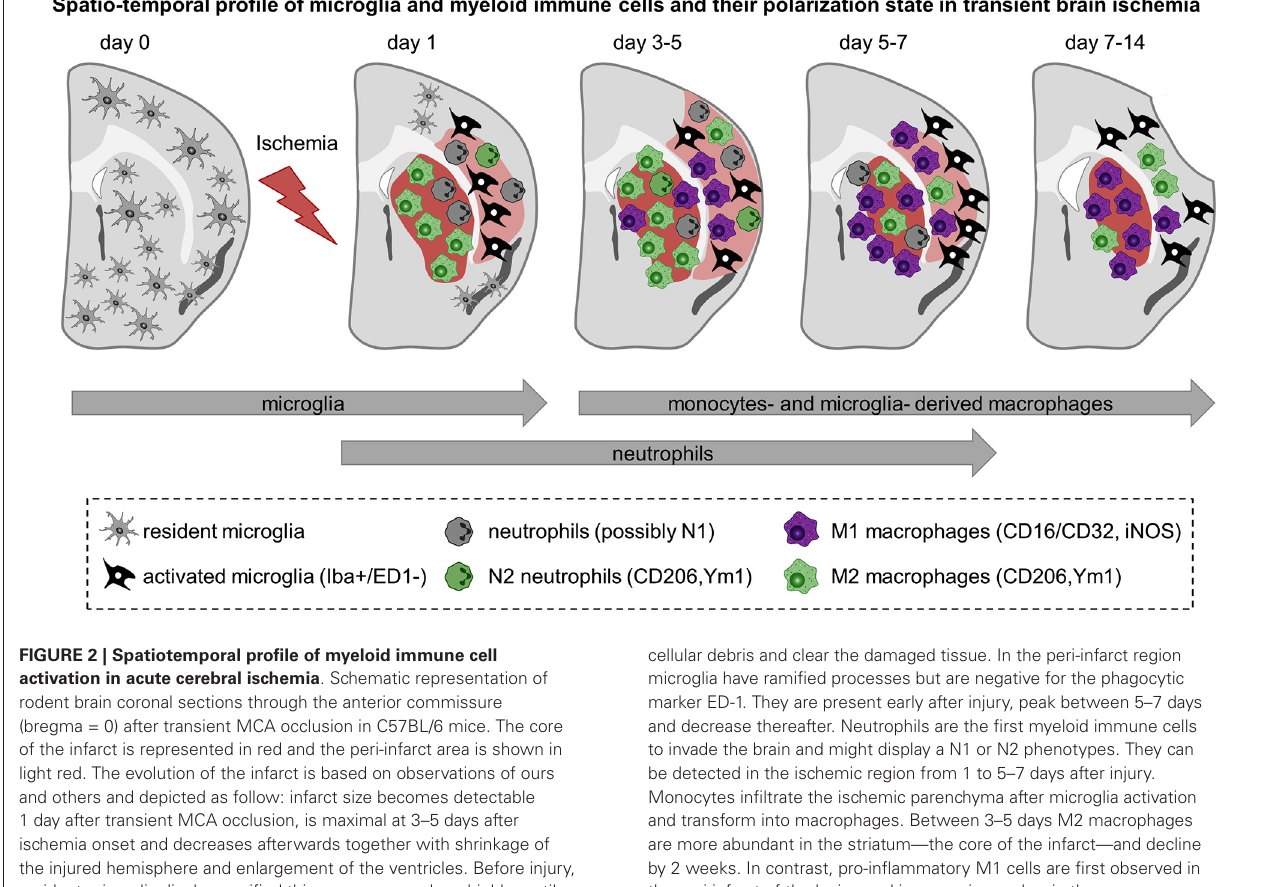
FIGURE 2 | Spatiotemporal profile of myeloid immune cell activation in acute cerebral ischemia . Schematic representation of rodent brain coronal sections through the anterior commissure (bregma = 0) after transient MCA occlusion in C57BL/6 mice. The core of the infarct is represented in red and the peri-infarct area is shown in light red. The evolution of the infarct is based on observations of ours and others and depicted as follow: infarct size becomes detectable 1 day after transient MCA occlusion, is maximal at 3–5 days after ischemia onset and decreases afterwards together with shrinkage of the injured hemisphere and enlargement of the ventricles. Before injury, resident microglia display ramified thin processes and are highly motile. They scan their microenvironment to detect any disturbances. Cerebral ischemia triggers microglia to become activated and to display distinct shapes and expression patterns upon the course of reperfusion. Based on findings depicted here, microglia become activated at the onset of cerebral ischemia—as early as 1 day after injury—and further develop into macrophages. In the core of the infarct, microglia are round-shaped, expressed ED-1 and display a M2 phenotype aimed at phagocytize the